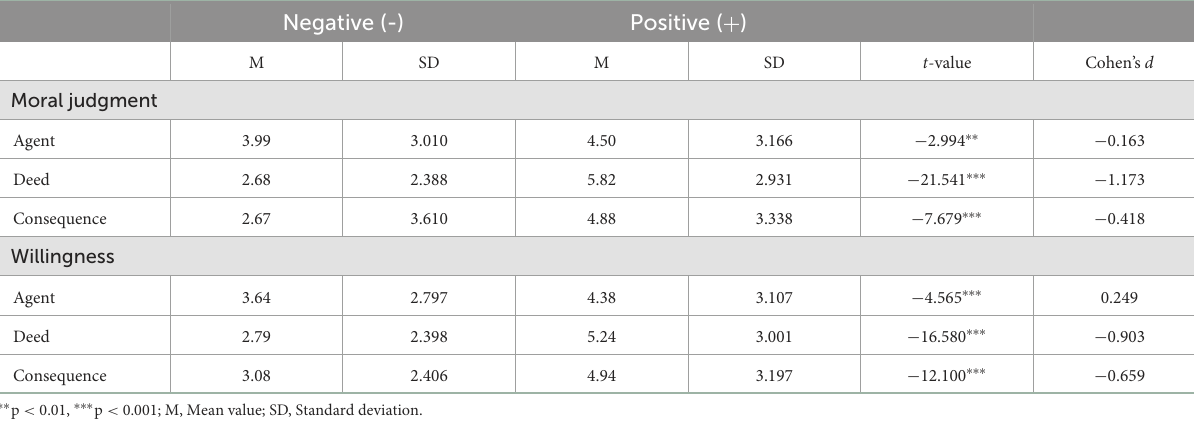
TABLE 3 Mediator variable model of the conditional mediation model ( N =